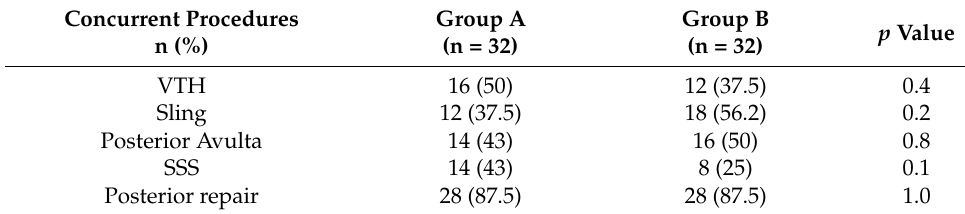
Table 3. Concurrent procedures.